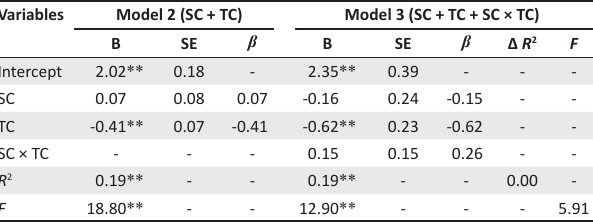
TABLE 6: Moderation effects between SC + TC + SC ×